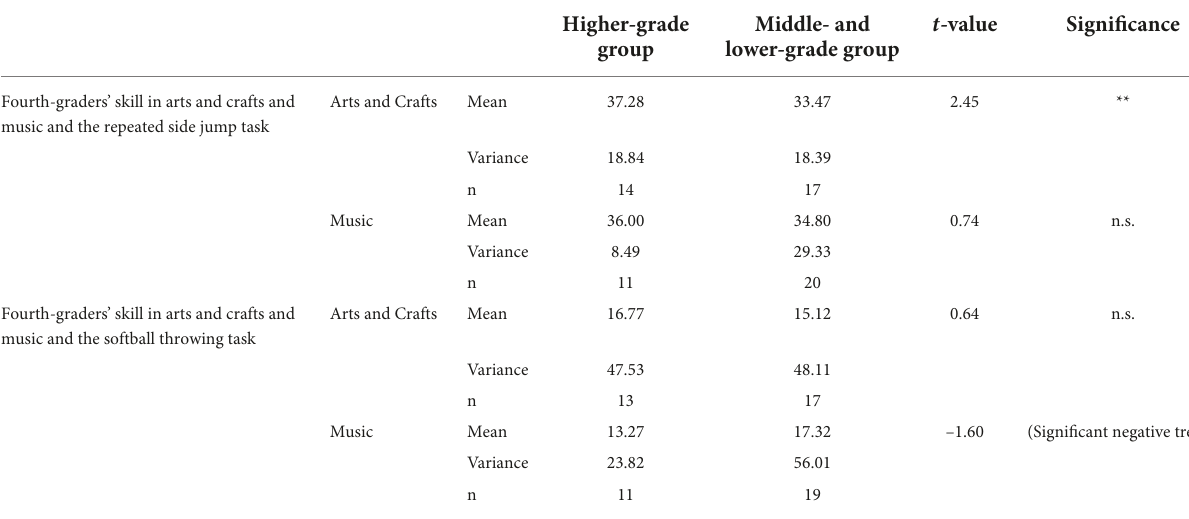
TABLE 4 Fourth-grade students’ skill in arts and crafts and music and the repeated side jump task, softball throwing task (September–December 2011).